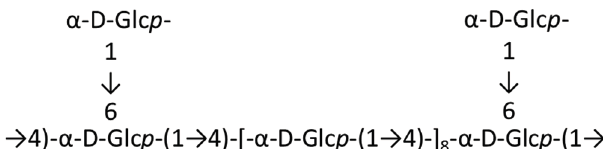
Figure 1. Predicted structure of MP-I ( 3 ), isolated from Mytilus coruscus